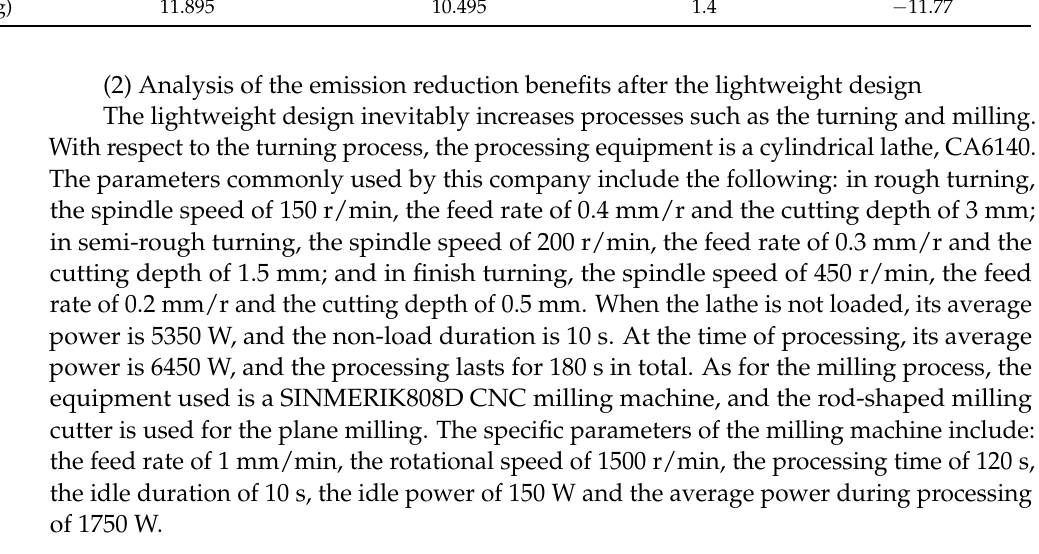
Table 2. Comparison of the mechanical properties of the wheel hub before and after the light ‐ weight design.